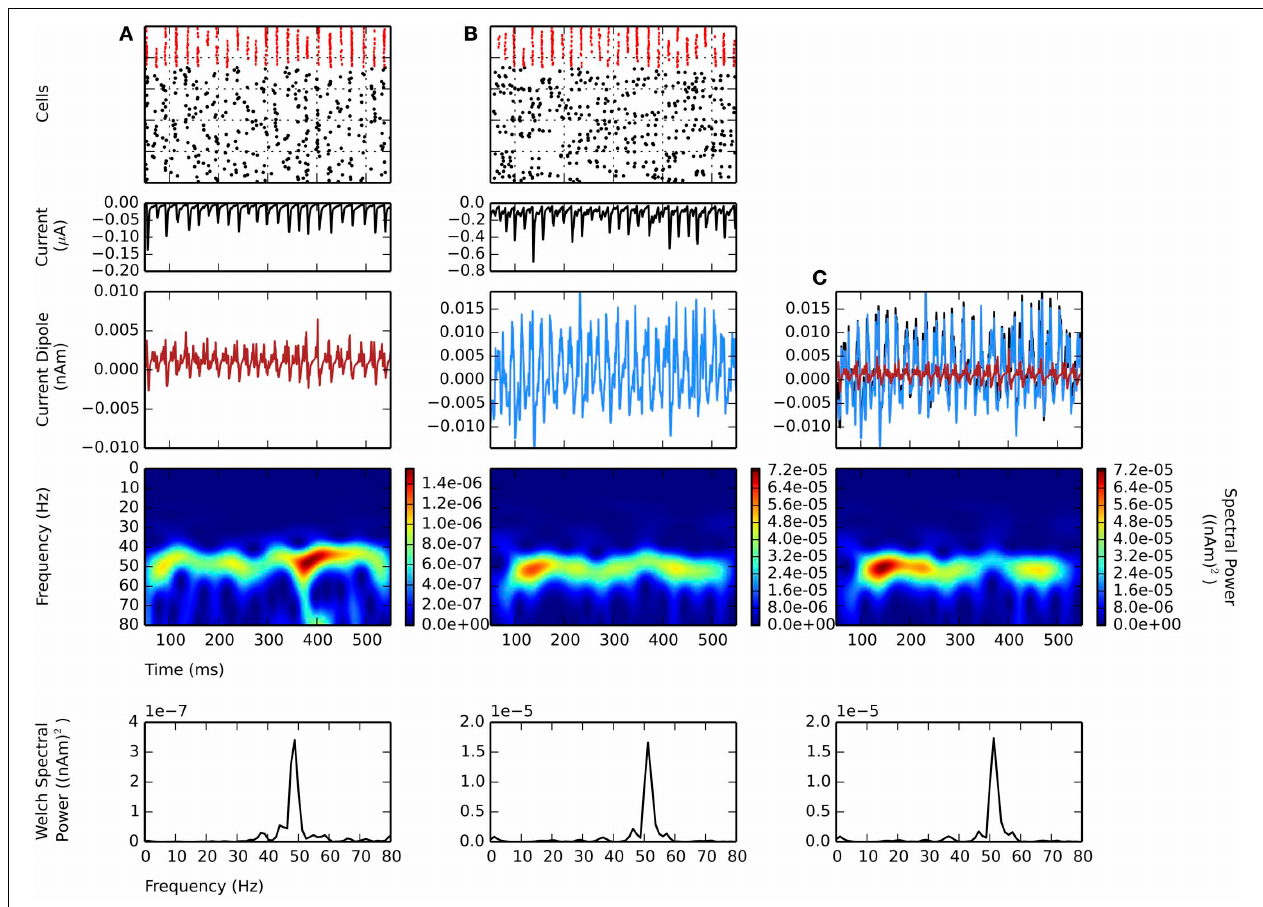
FIGURE 5 | Larger amplitude L5 weak PING rhythms dominate L2 weak PING rhythms in current dipole due to longer E cell dendrites in L5. From top to bottom: spike rastergram of E cells (black) and I cells (red); aggregate GABA A -ergic current contribution to E cell somata ( μ A, black); net current dipole for E cells in layer (nAm); Morlet spectrogram of net current dipole [(nAm) 2 ]; stationary Welch periodogram for net current dipole [(nAm) 2 ]. g pois = 0.75 × 10 − 2 mS/cm 2 . Simulations shown from 50 to 550ms. (A) Independent weak PING in L2 shows ∼ 50Hz activity in Morlet spectrogram.